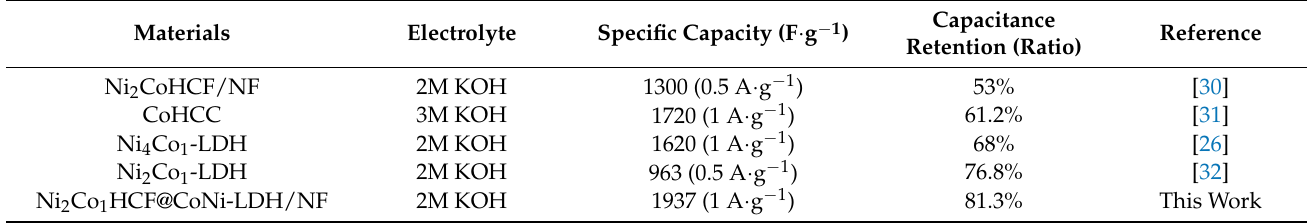
Table 2. Comparison of the specific capacities and rate capabilities of several types of